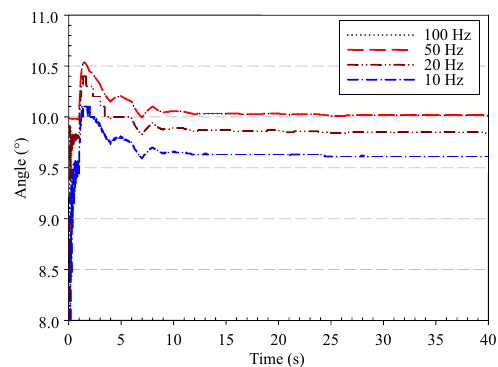
Fig. 4 Sample frequencies of the simulation results.